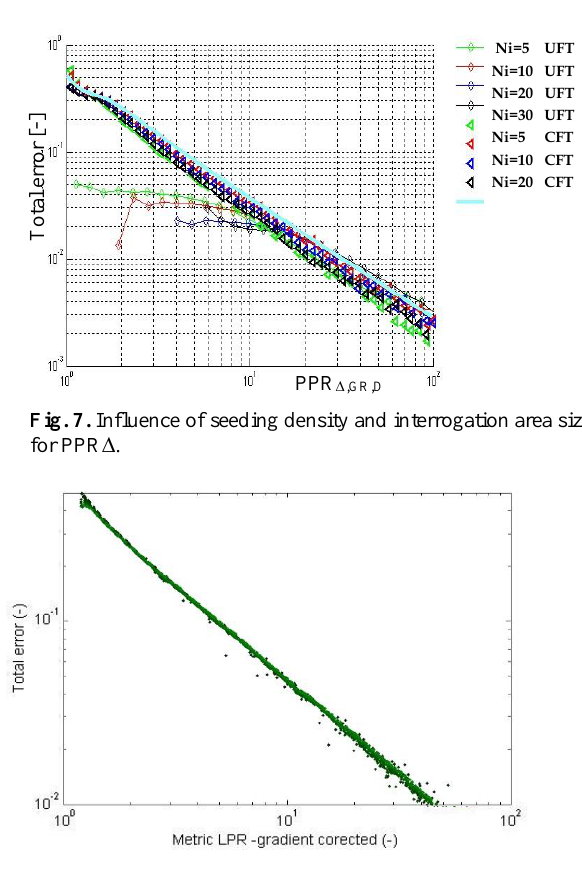
Fig. 8. Influence of seeding density and interrogation area size for fully corrected LPR